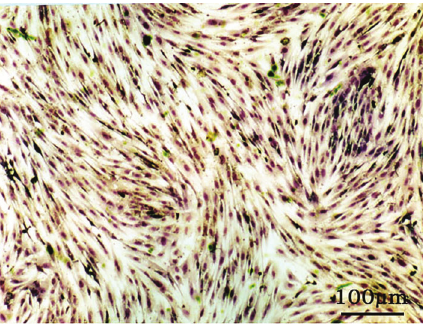
Figure 2. The control group fi broblasts reached con fl uence and displayed a fi ngerprint-shaped order at 5 days. HE staining, (cid:1)